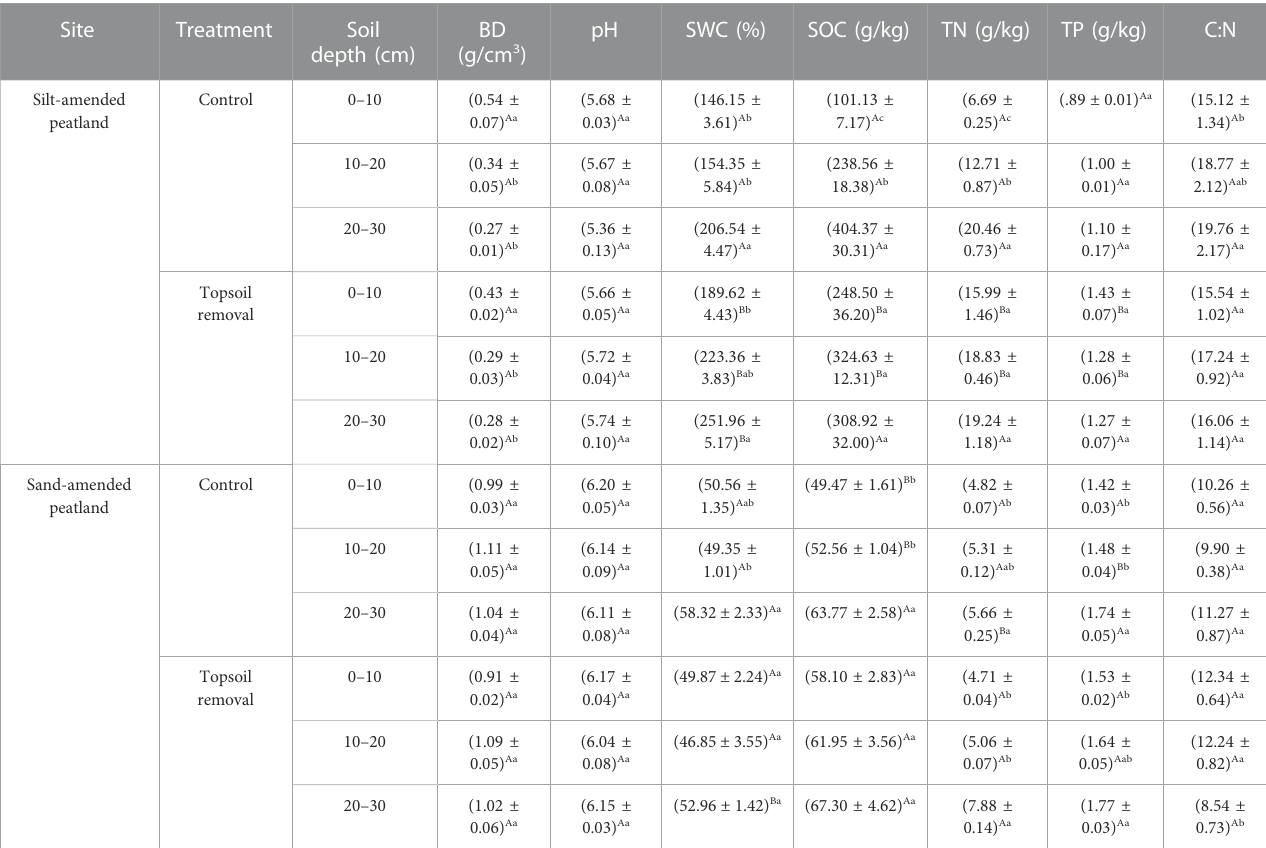
TABLE1Soilpropertiesinsilt-amendedandsand-amendedpeatlands.Differentcapitallettersrepresentsigni fi cantdifferencesbetweenthetwotreatmentswithinthe same soil layer and the same peatland site. Different lowercase letters represent signi fi cant differences between the three soil layers within the same treatment. ( p